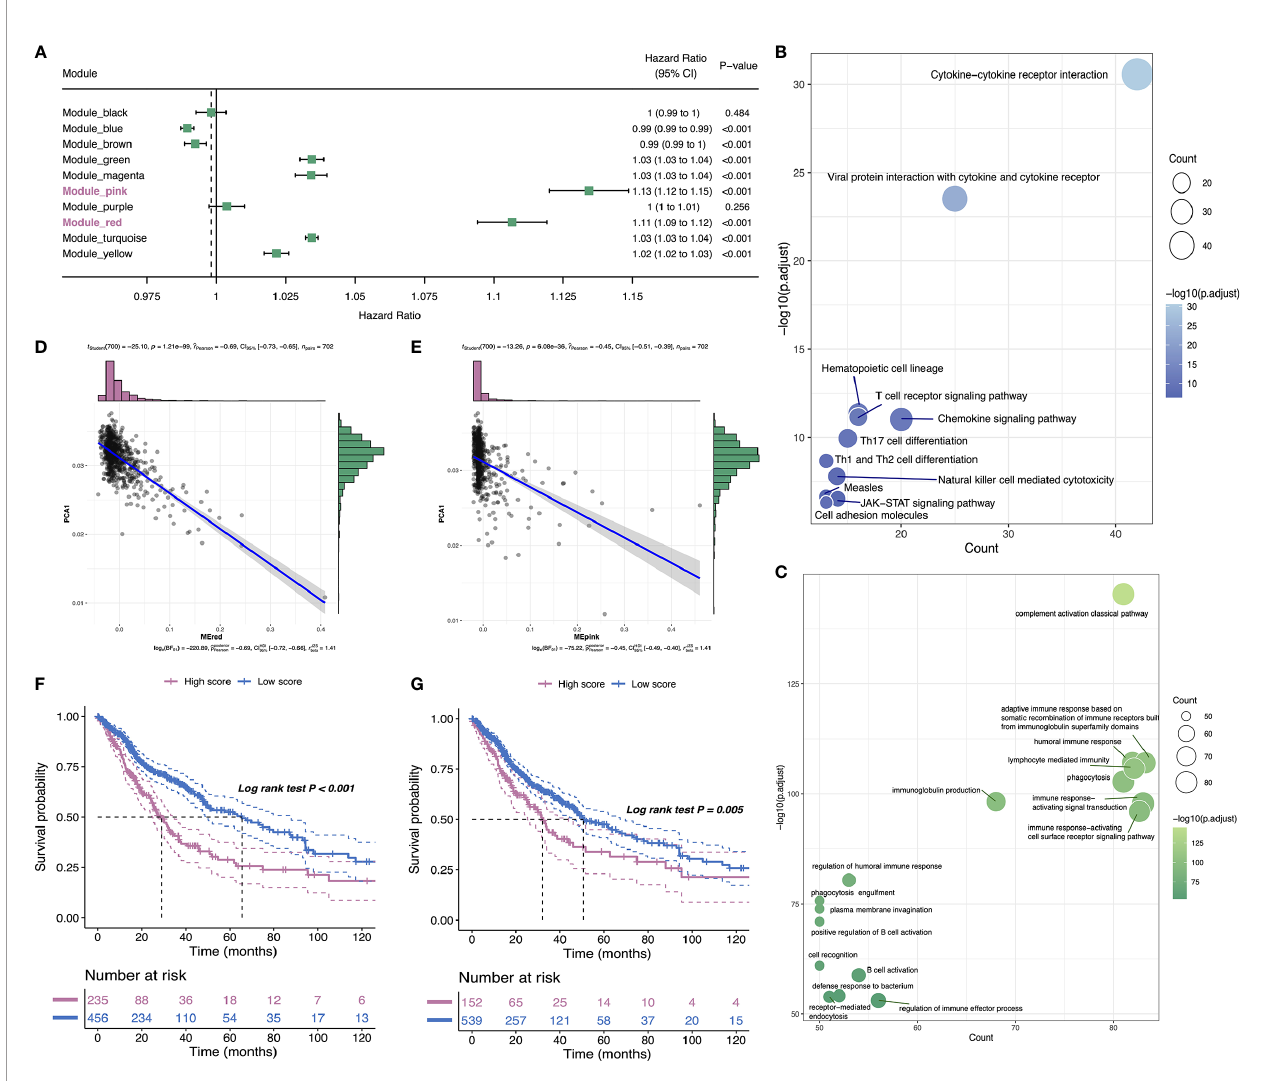
FIGURE 10 | Identi fi cation of immune hub genes of glioma. Forest maps of single factor survival analysis of 10 modules of glioma (A) . Bubble plots showing top KEGG terms enriched in the red (B) and top GO terms enriched in pink (C) modules. The dot size and color intensity represent the gene count and -log10 (adjusted p-value), respectively. Correlation between PC1 and red (D) and pink (E) module feature vector. Differential prognosis in red (F) and pink (G) modules with high and low